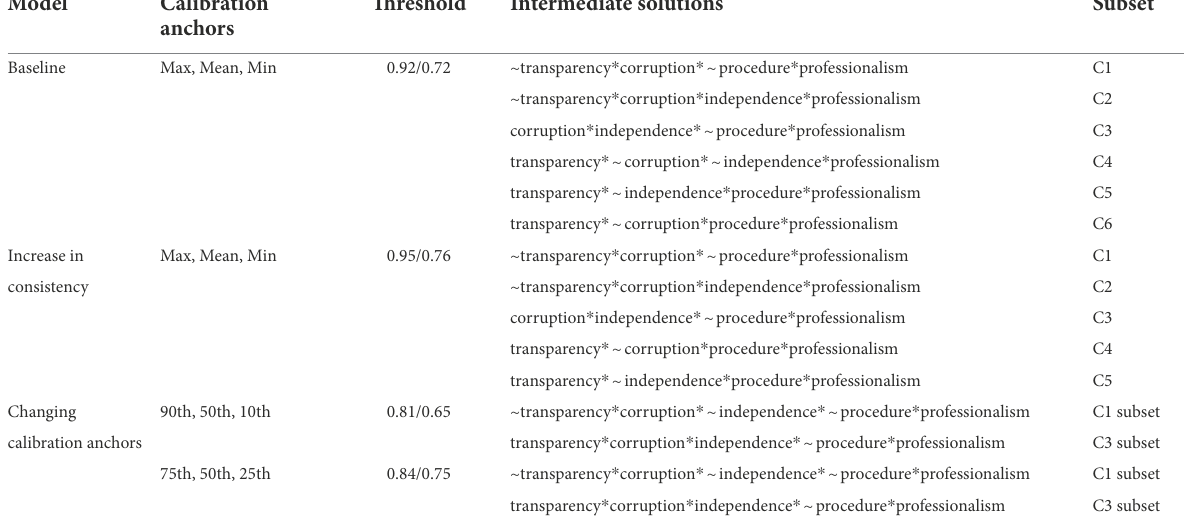
TABLE 5 Results of robustness